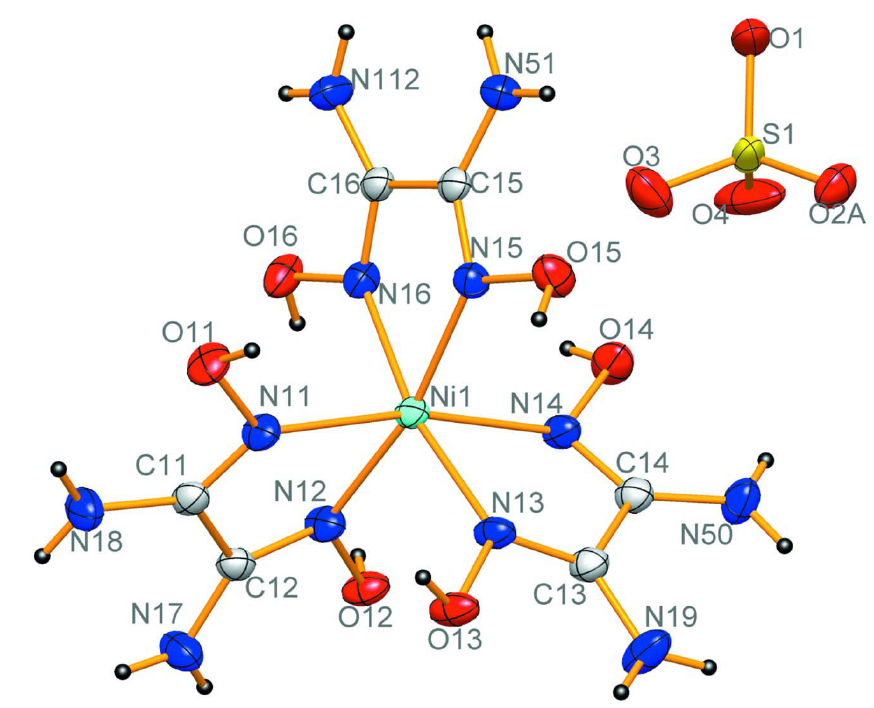
Figure 1 Ionic constituents of the title compound. Displacement ellipsoids are drawn at the 50% probability level.